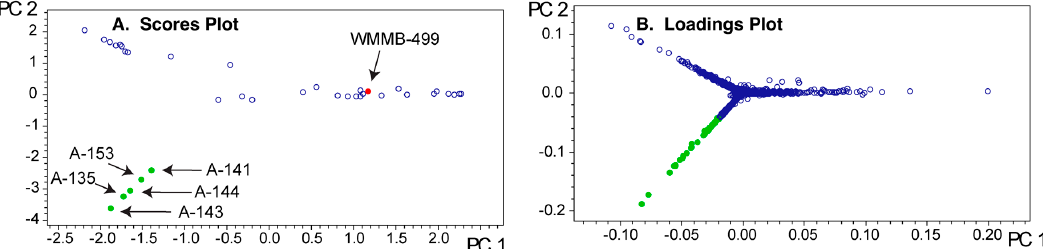
Figure 7. PCA model for Dataset two. ( A ) In contrast to Figure 6A, the scores plot showing PC1 versus PC2 shows that WMMB-499 is unique relative to the other strains; ( B ) Similarly, the loadings plot provides clear evidence for unique molecular features associated with WMMB-499. ( C ) Examples of base peak chromatograms showing that WMMB-499 yielded lower overall ion intensity. Overall, Figures 6 and 7 highlight that the discovery of interesting molecules from a collection of bacterial strains is dependent on the strains analyzed. For our workflow, we analyze